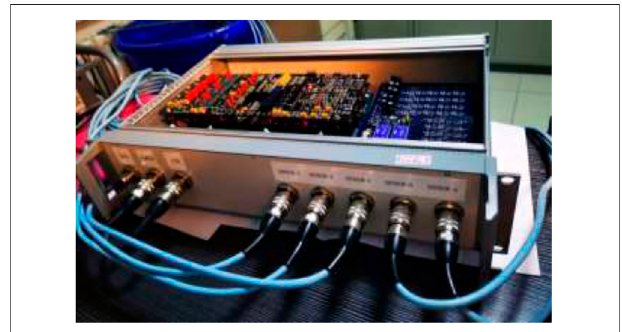
FIGURE 1 | Highly accurate temperature measurement principle prototype.